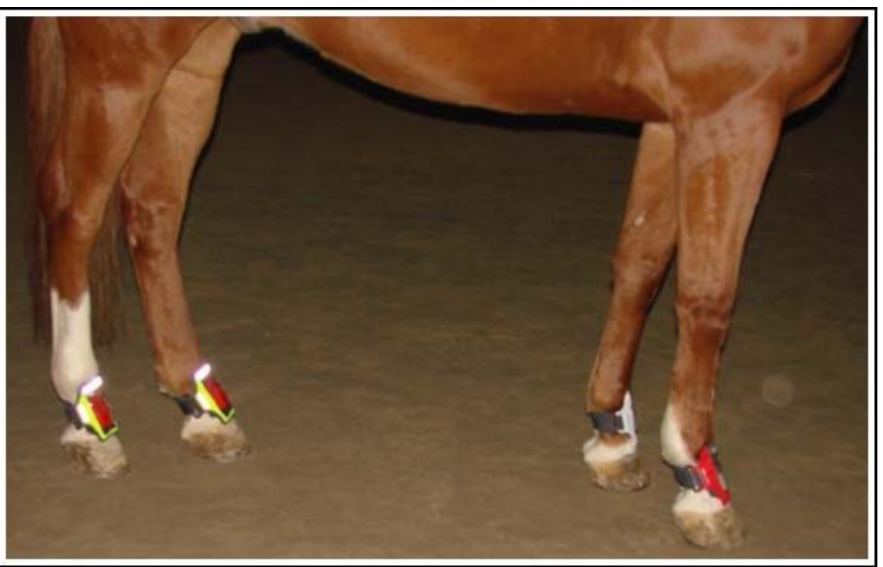
Figure 3. Illustration of correct fitting of the Lameness Detector 0.1 system with adjustable straps to the dorsal aspect of a horse’s pasterns.